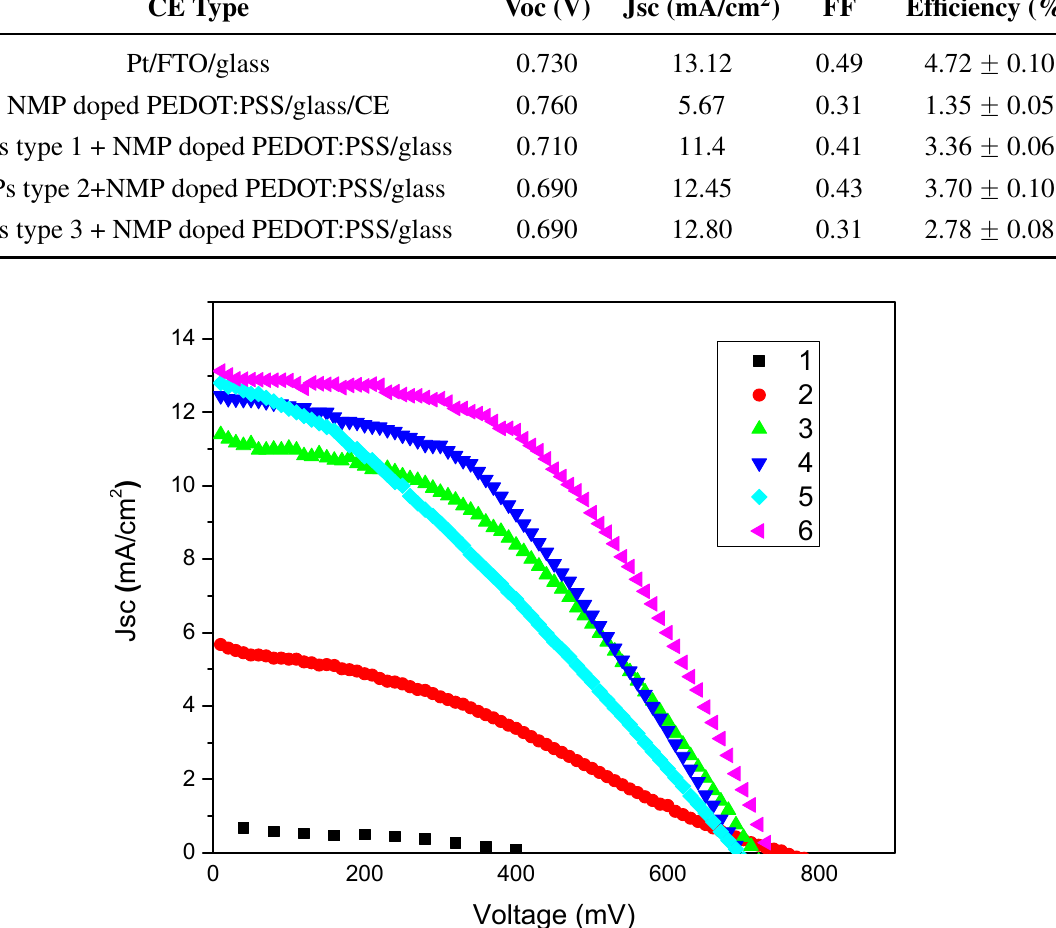
Figure 5. The photovoltaic (J–V) curves of: (1) pure PEDOT:PSS (2) NMP doped PEDOT:PSS; (3) GNPs type 1 + NMP doped PEDOT:PSS; (4) GNPs type 2 + NMP